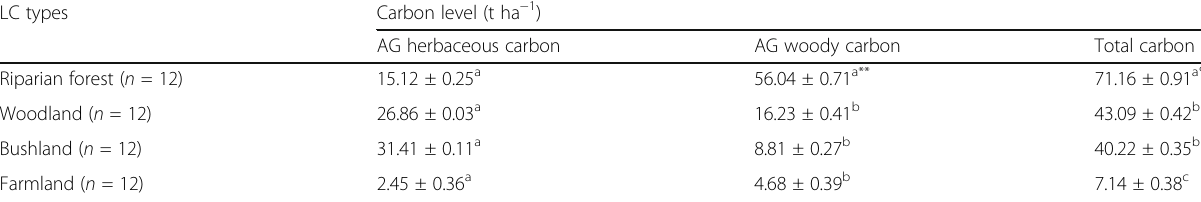
Table 3 Carbon stocks in the different land cover (LC) types of BES